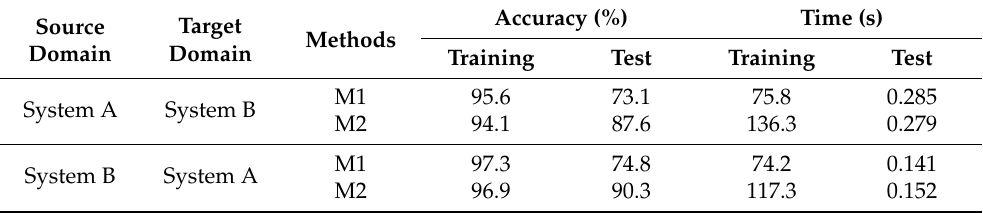
Table 1. The training and testing results of the FLS model after exchanging the source and target domains. It should be noted that the test time represents the computation time of the model for one fault in the target domain.